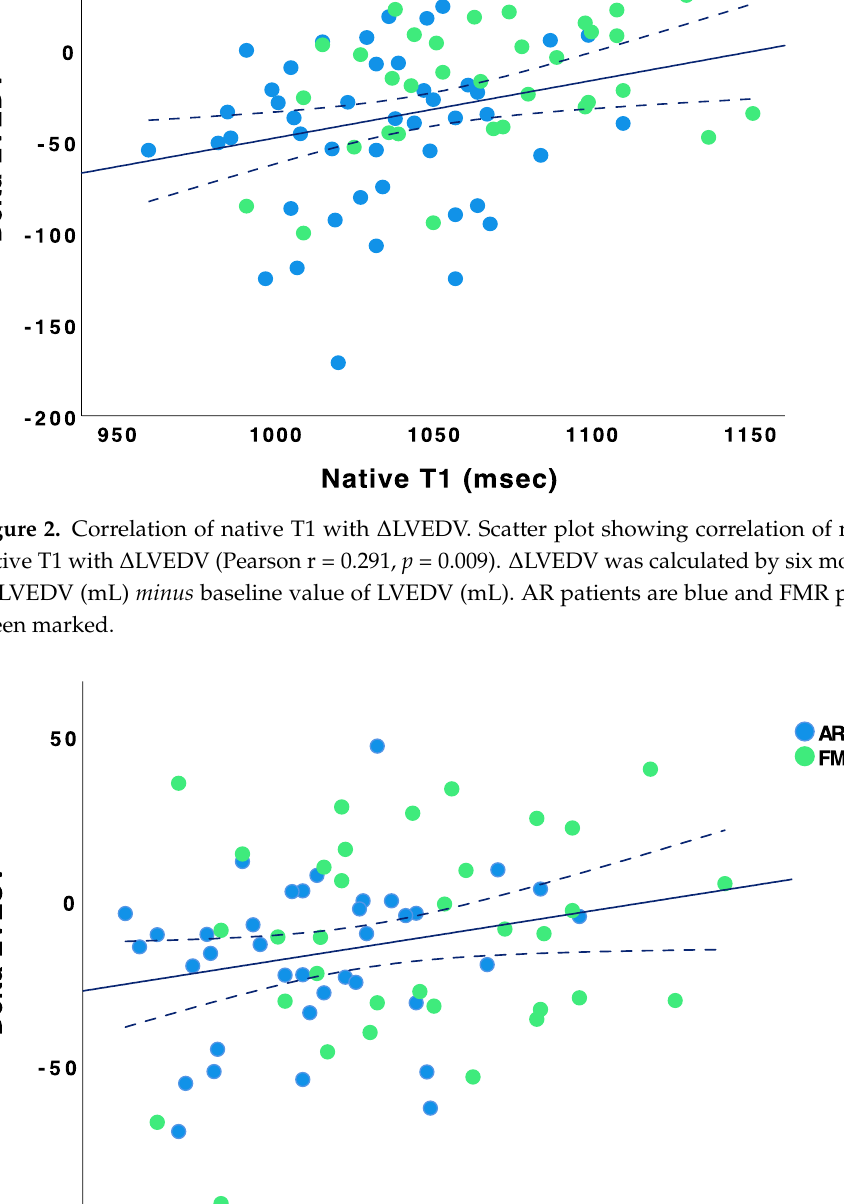
Figure 1. Bar Chart showing the distribution of native T1 values. Baseline native T1 values did not correlate with ∆LVEF (Pearson r = −0.002, p = 0.98), ∆LVEDD (Pearson r = 0.02, p = 0.84), and ∆LVESD (Pearson r = −0.05, p = 0.71). However, baseline native T1 values correlated with ∆LVEDV (Pearson r = 0.291, p = 0.009) and ∆LVESV (Pearson r = 0.292, p = 0.015) (see Figures 2 and 3).